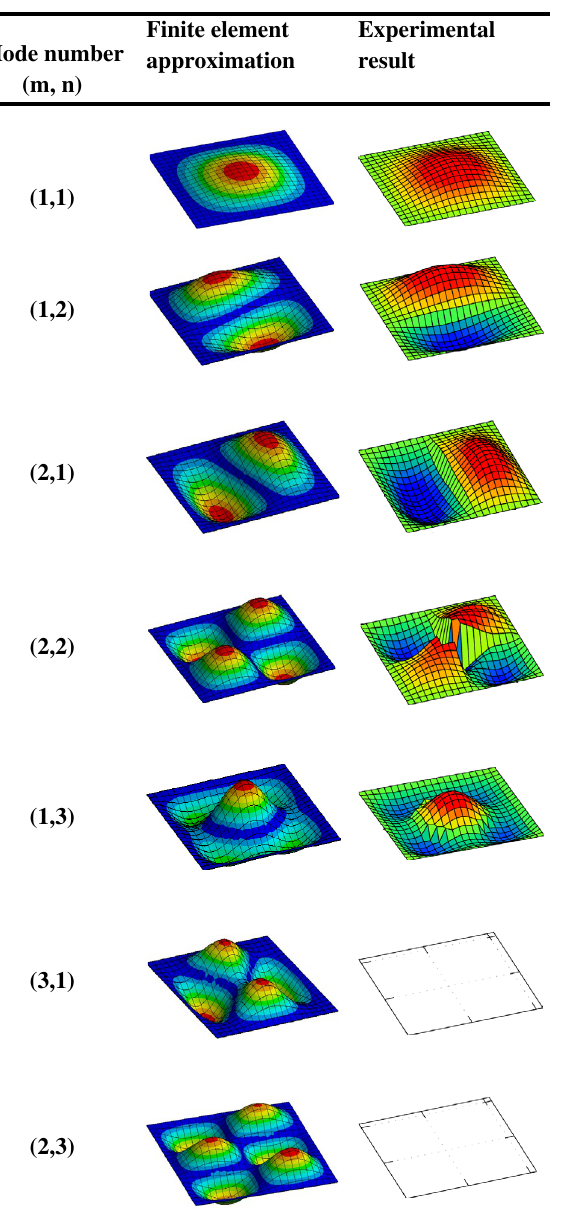
Figure 5. First twelve mode shapes comparison between finite element approximation and measured results for the aluminium panel excited by a loudspeaker placed at FBC source